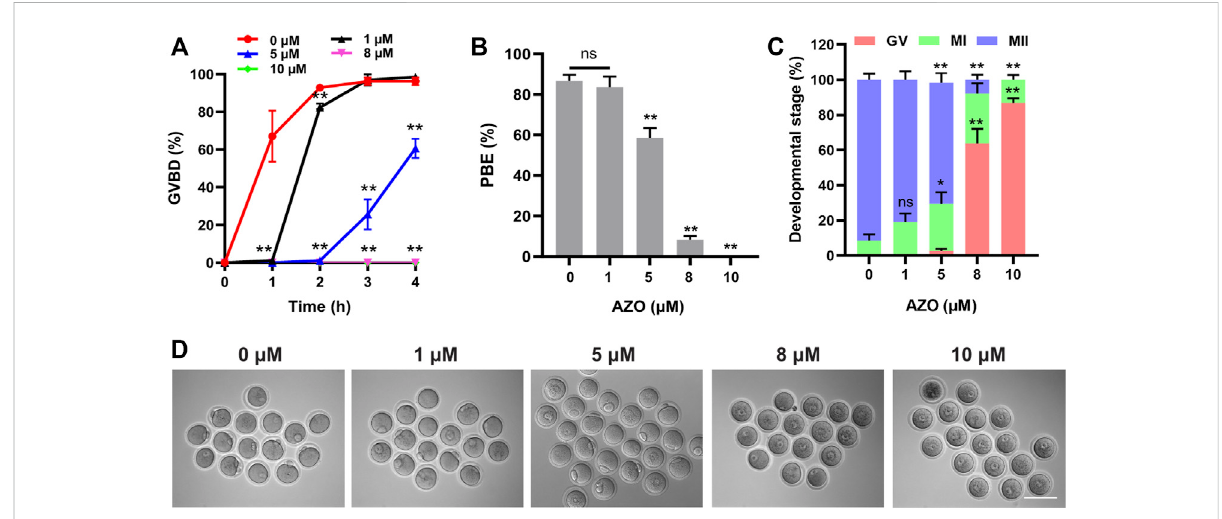
FIGURE 1 The effect of AZO on oocyte meiotic maturation is dose-dependent. (A) Oocytes were treated with different doses of AZO following IBMX release. The percentage of GVBD is expressed as mean ± SEM from three independent experiments. (B) After 16 h of culture with AZO treatments using different doses, the percentage of polar body extrusion is expressed as mean ± SEM from three independent experiments. (C) Percentage of AZO-treated oocytes at GV, MI, and MII stages. (D) Representative images of oocytes at 16 h of culture with different dose-treatments of